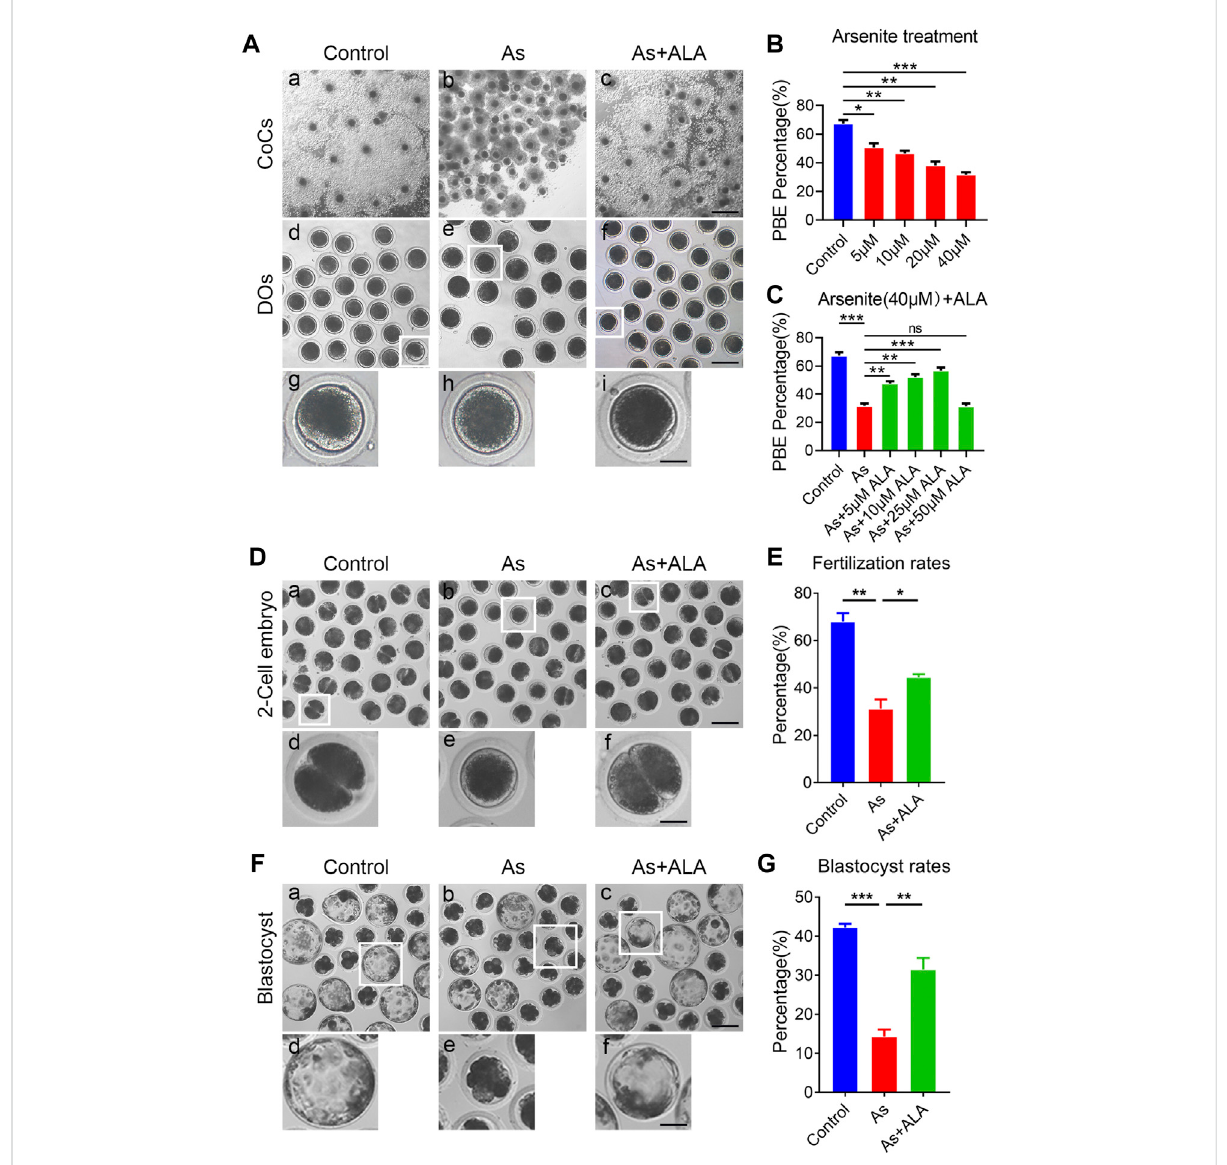
Effects of ALA supplementation on the porcine oocyte maturation and fertilization ability in arsenite-exposed oocytes. (A) Representative images of in vitro matured oocytes in control, arsenite-exposed and ALA-supplemented groups. Cumulus cell expansion of oocytes and PB1 extrusion were imaged by the inverted light microscope. Scale bar: 350 µm (a-c); 150 µm (d-f); 50 µm (g-i). (B) The rate of polar body extrusion were calculated in control and different concentrations of arsenite-exposed groups (5, 10, 20 and 40 µM) after culture for 44 h in vitro . (C) The rate of polar body extrusion were calculated in control, 40 µM arsenite-exposed and different concentrations of ALA-supplemented groups (5, 10, 25 and 50 µM) after in vitro maturation. (D) Representative images of 2-cell embryos in control, arsenite-exposed and ALA-supplemented groups. Scalebar:120 µm(a-c);40 µm(d-f). (E) Therate of invitro fertilizationwerecalculated incontrol,arsenite-exposedandALA-supplementedgroups. (F) Representative images of blastocysts developed from the fertilized control, arsenite-exposed and ALA-supplemented groups. Scale bar: 150 µm (a-c); 60 µm (d-f). (G) The rate of blastocysts were calculated in control, arsenite-exposed and ALA-supplemented groups. Data were presented as mean percentage (mean ± SEM) of three independent experiments. * p < 0.05, ** p < 0.01, *** p <